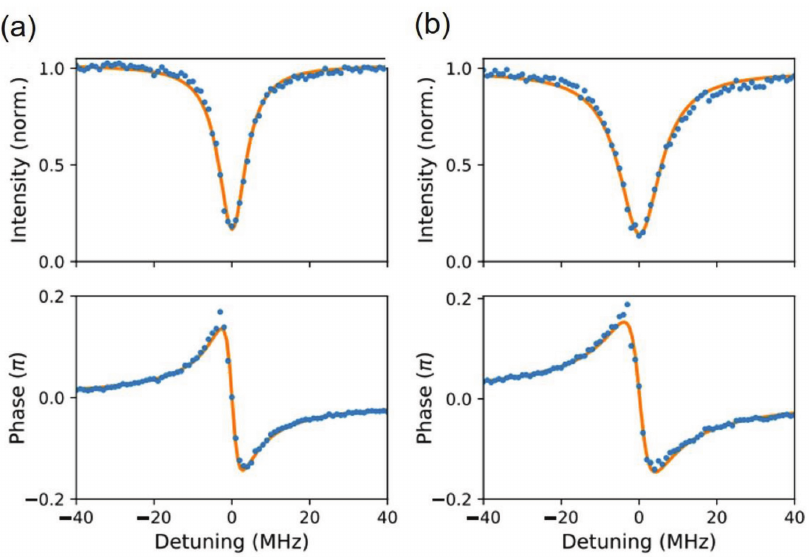
Figure 12: The measured intensity and phase profiles (blue dots) of the resonance at 0.5561 THz at (a) 7 ppm per volume and (b) 120 ppm per volume H O vapor concentrations. Reprinted from Ref. [211]. 2